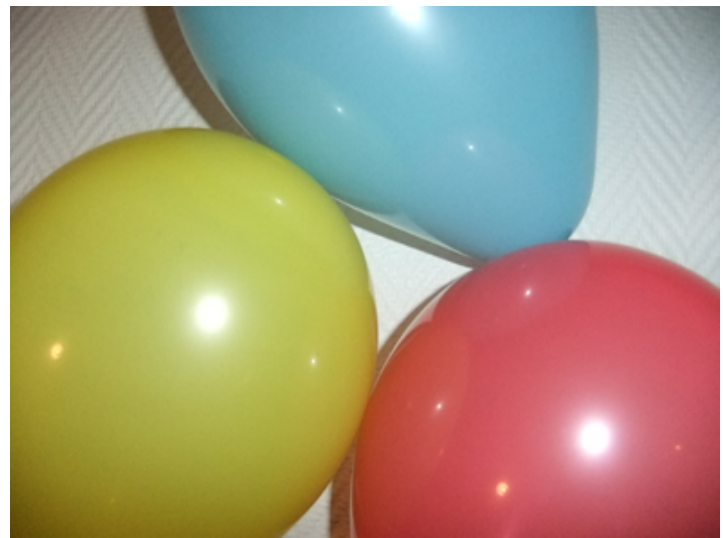
Figure 3. Control group picture used in Study